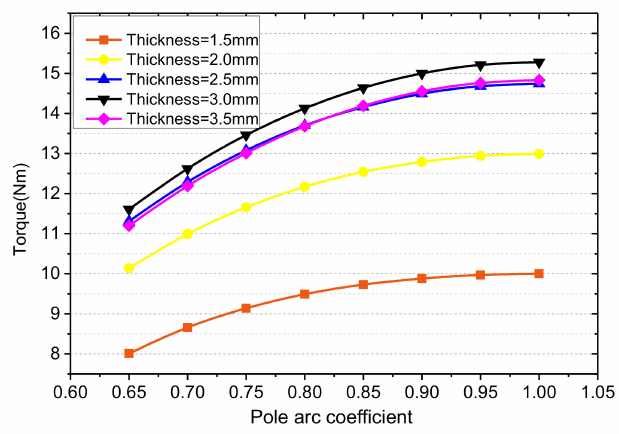
Figure 19. T max versus pole arc coe ffi cient for several permanent magnet thickness.